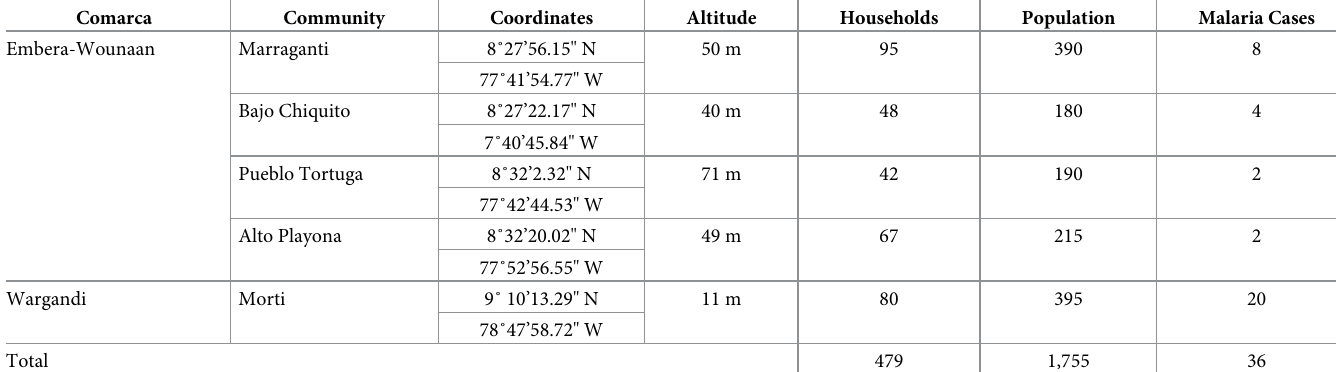
Table 1. Epidemiological information from the studied communities in Darie´n, 2016.